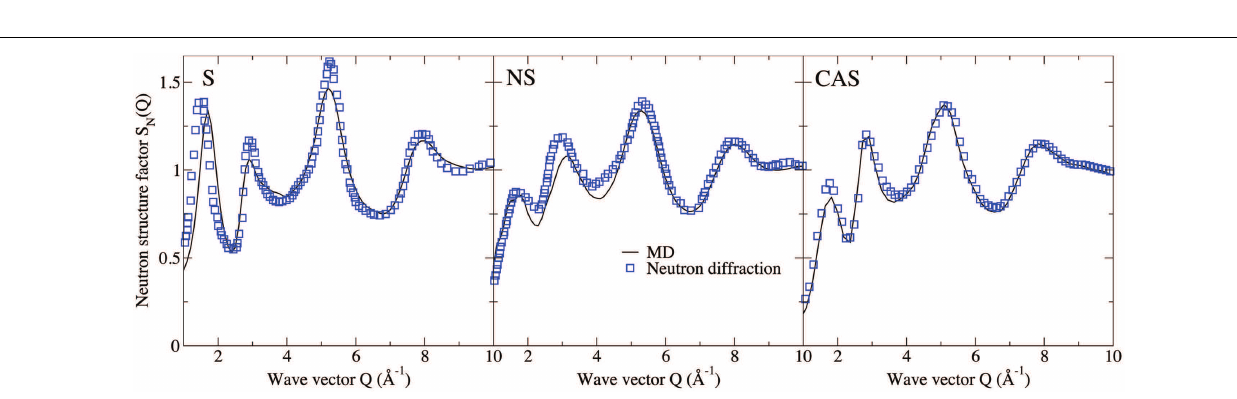
the fracture, with exception of some areas in CAS. This